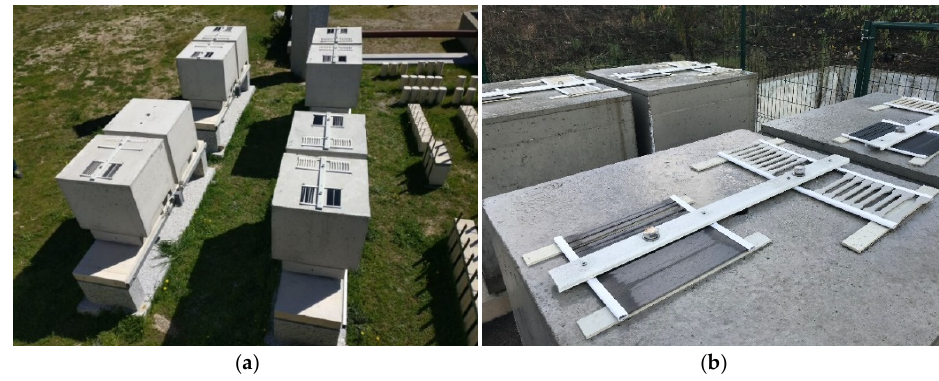
Figure 4. Experimental stations ( a ) E4 and ( b ) E3.